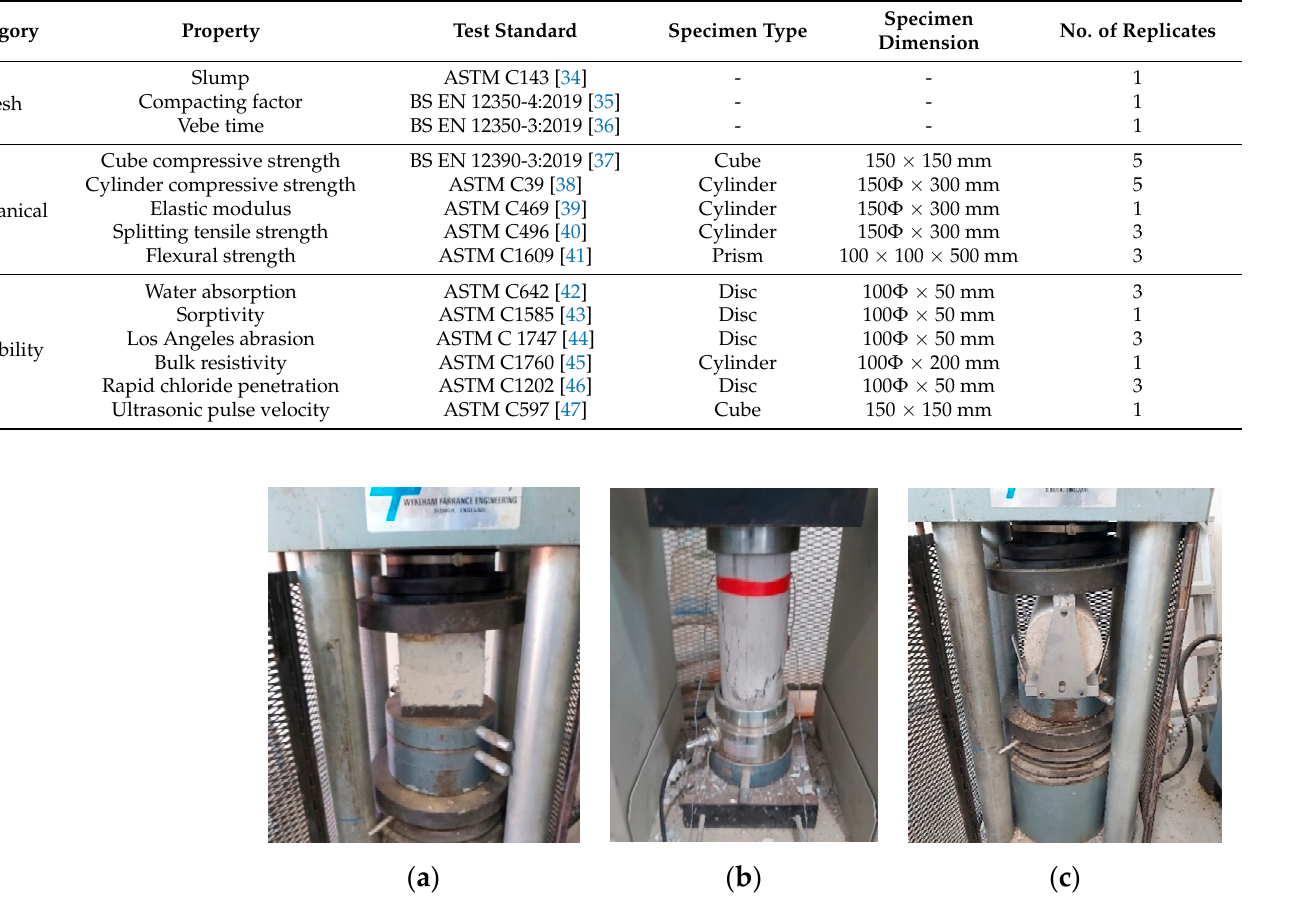
Table 5. Testing methods and specimen details.